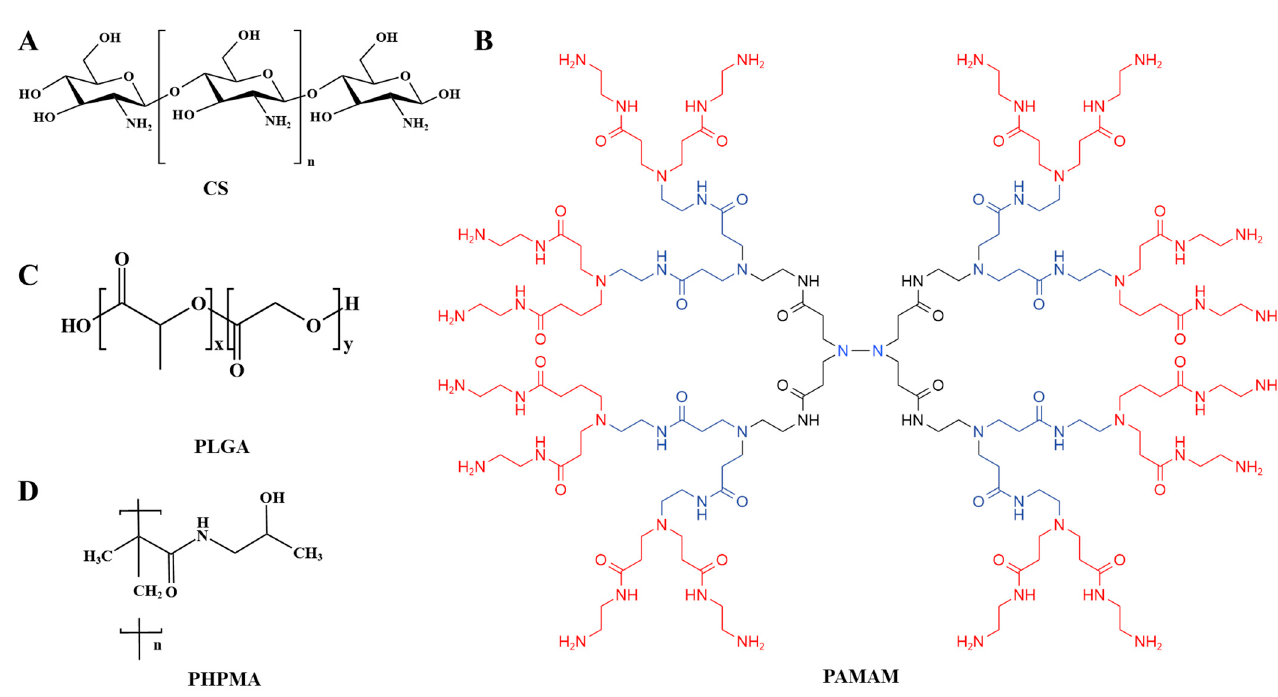
Figure 2. Structure of polymers for the treatment of asthma: ( A ) CS, ( B ) PAMAM, ( C ) PLGA, ( D ) PHPMA.